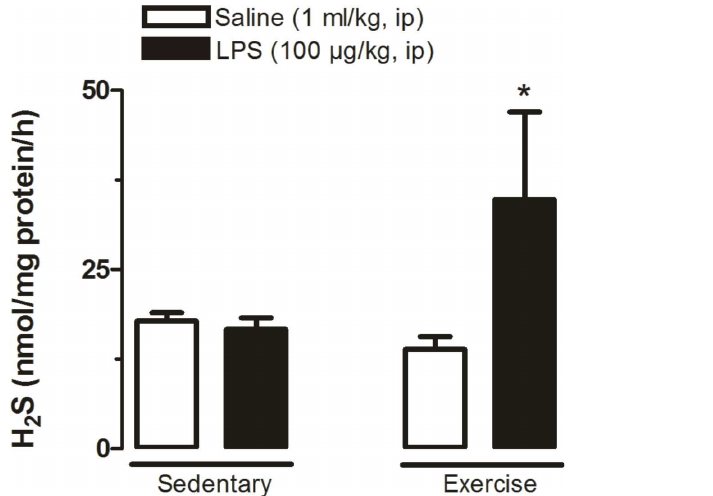
Fig 2. H 2 S levels in the POA at 120 min after systemicadministration of LPS or saline. Sedentary saline (n = 8), SedentaryLPS (n = 6), Exercisedsaline(n = 5) and ExercisedLPS (n = 5). * P < 0.05,ExercisedLPS vs. the other three